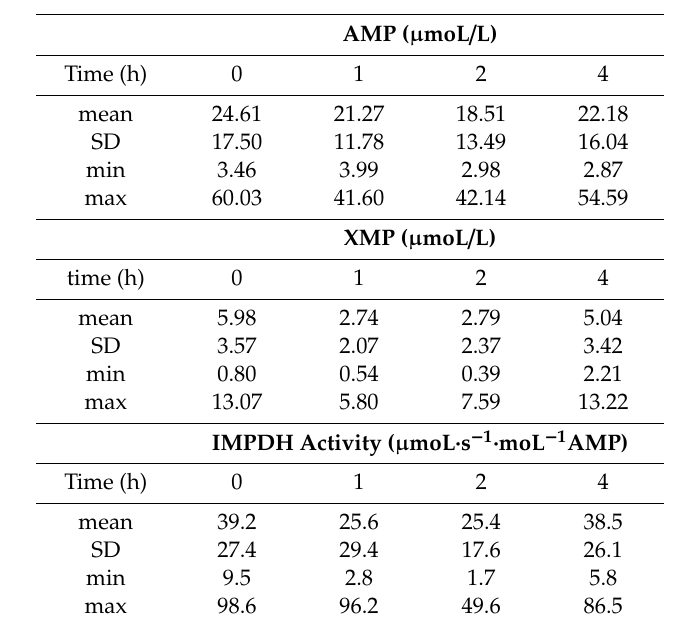
Table 2. AMP and XMP concentrations and calculated IMPDH activity in children ( n = 12) with nephrotic syndrome treated with MMF.